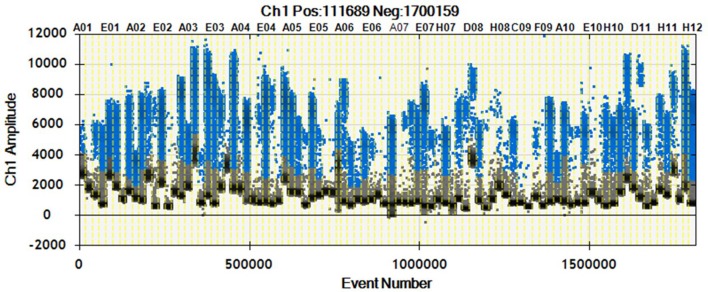
1D Plot representation. Droplet distribution for different miRNA assays evaluated in the same sample. 1D Plot representation shows positive (blue) and negative (black) droplet amplitudes. The fluorescence amplitude can change according to the assay.